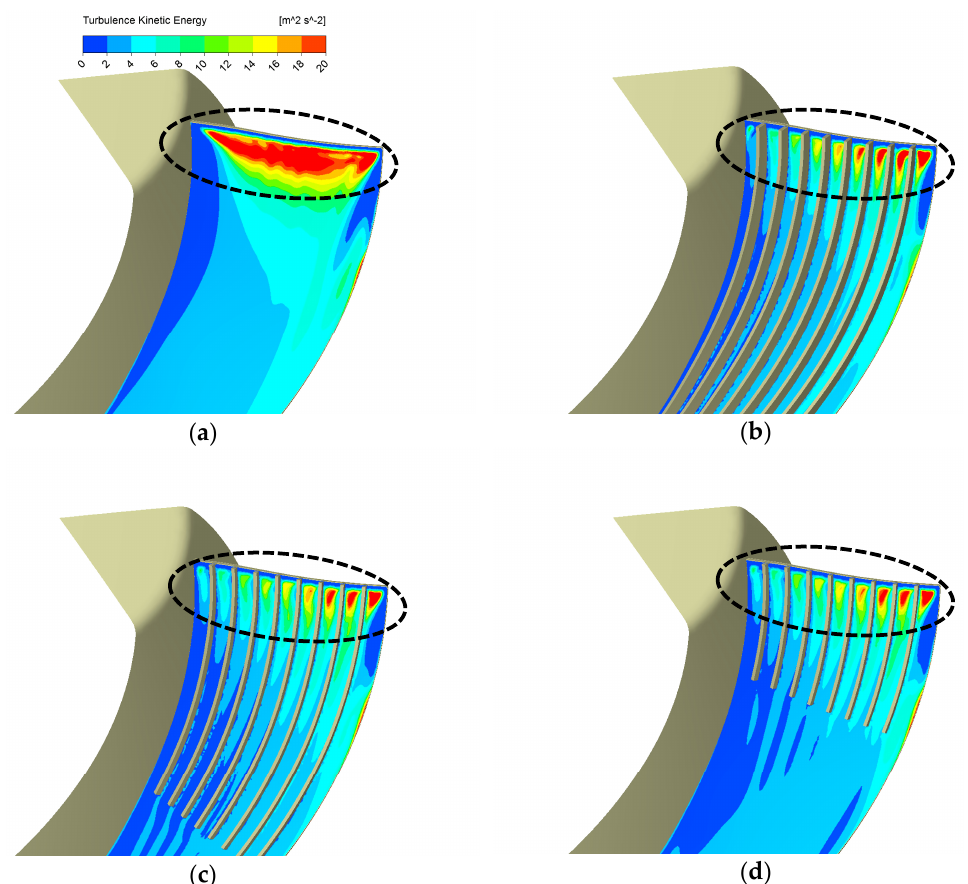
Figure 11. TKE contours on Off_Suc_1 mm of the basic design and various riblets on suction face designs: ( a ) Basic, ( b ) Rib_N9_H7.6, ( c ) Rib_N9_H4.2_L2/3, ( d ) Rib_N9_H4.2_L1/3.